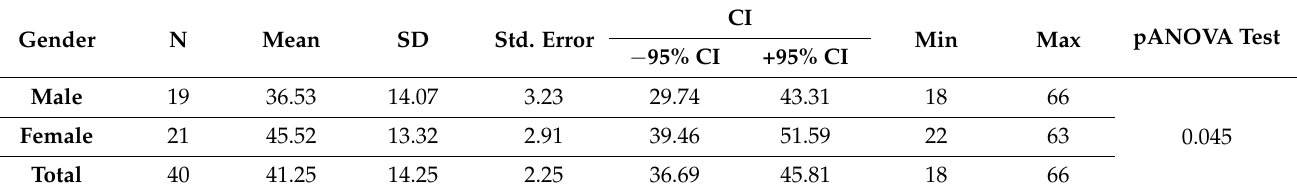
Table 1. Descriptive statistical indicators of age